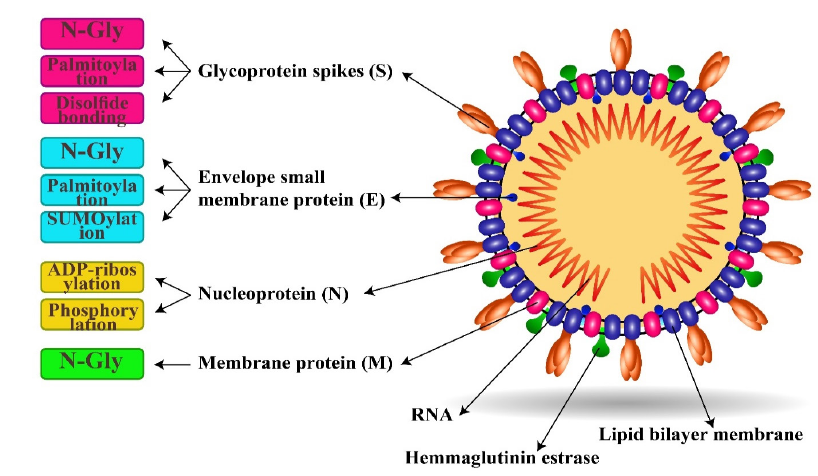
Figure 1. Schematic diagram showing the PTMs of coronavirus S, E, N, and M